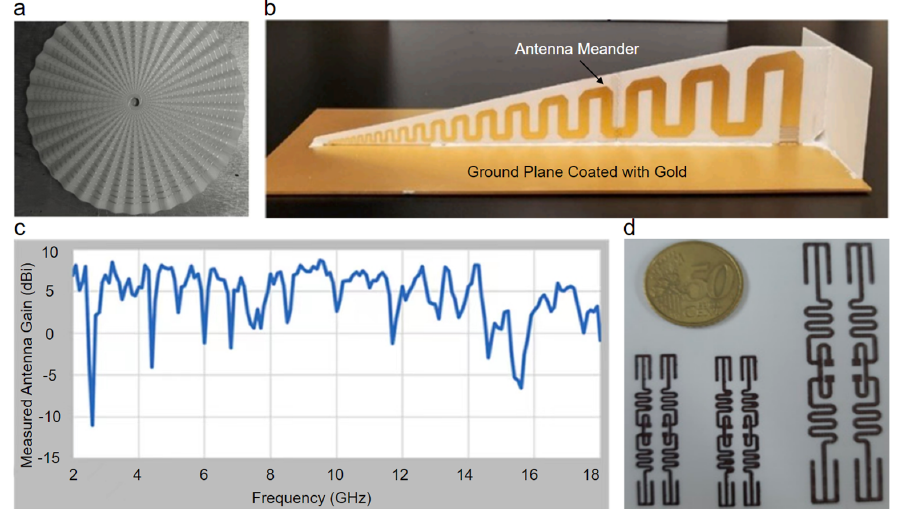
Figure 11. Multi-material 3D-printed ceramic microstrip antennas. ( a ) Photograph of the spiral microstrip antenna hybrid printed by NanoParticle Jetting™ and AJP [23]. ( b ) Photograph of the broadband microstrip antenna hybrid printed by DLP and AJP, and ( c ) measured gain versus frequency at room temperature [241]. ( d ) Photograph of the fully inkjet-printed antenna circuits [192].